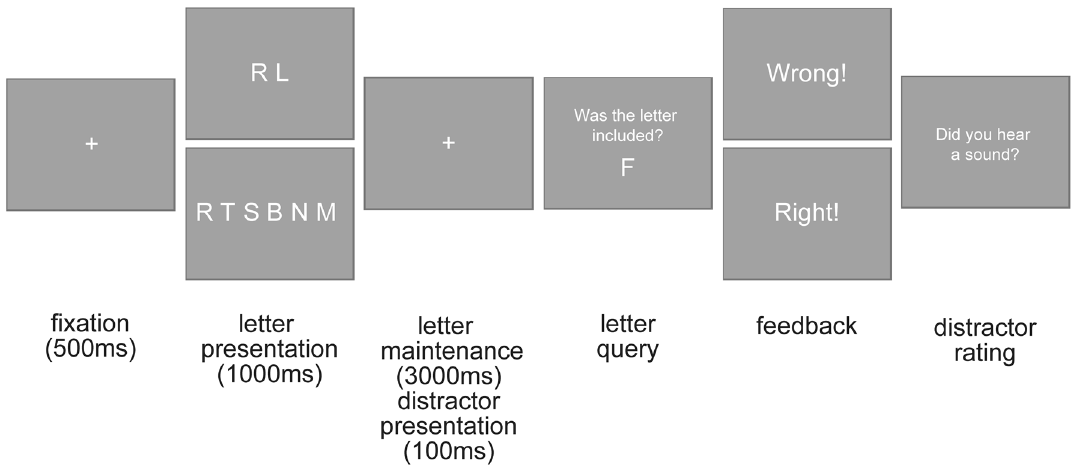
Figure 1. Illustration of the experimental